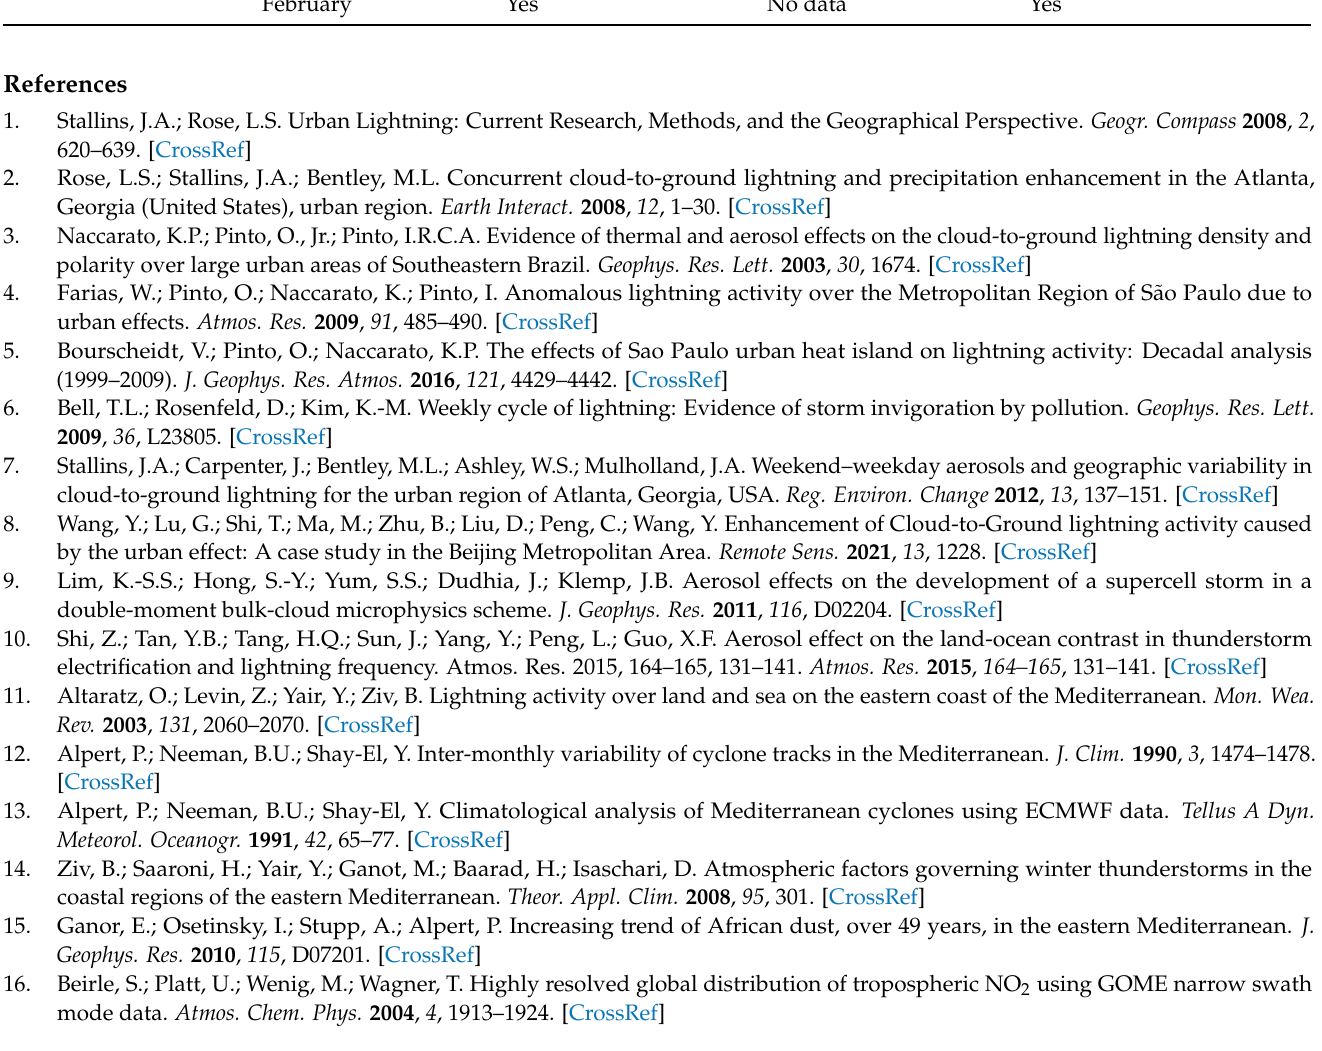
ENTLN Lightning Stroke Data